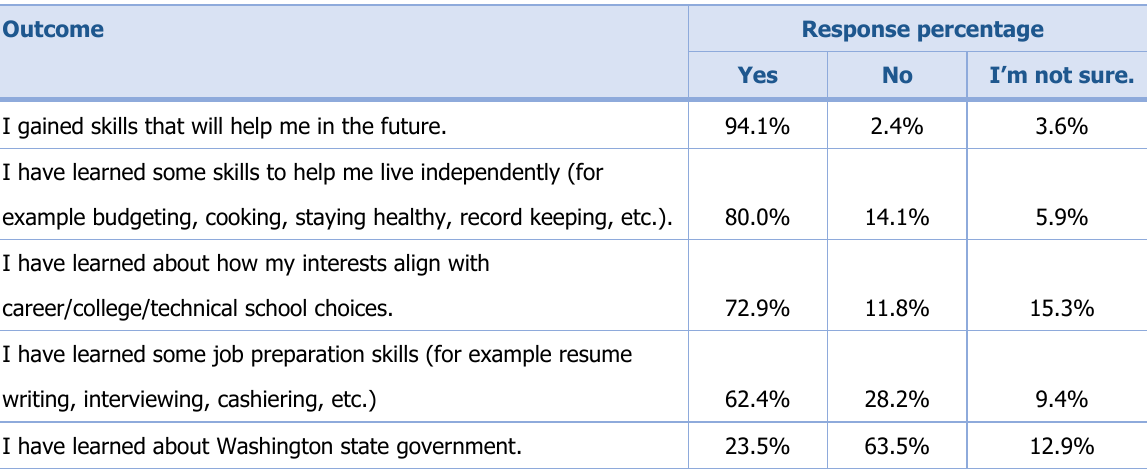
Table 2: Citizenship and Career/College Readiness Outcome Responses